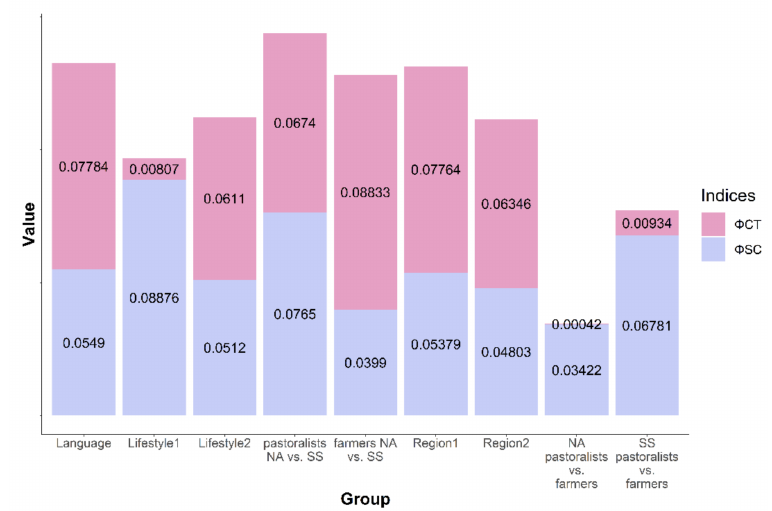
Figure 4. Values of two variation indices Φ CT in pink (for variation between groups) and Φ SC in violet (for variation among populations within the groups) from analysis of molecular variance (AMOVA) made for several groups defined by language, lifestyle, and geographic region (groups specified on x -axis).